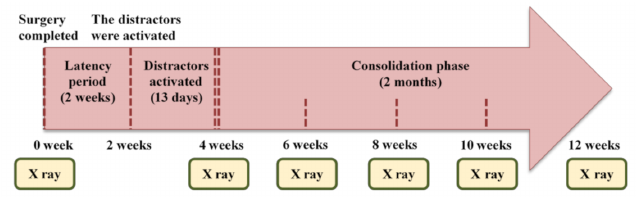
Figure 3. Whole experimental program diagram after surgery.